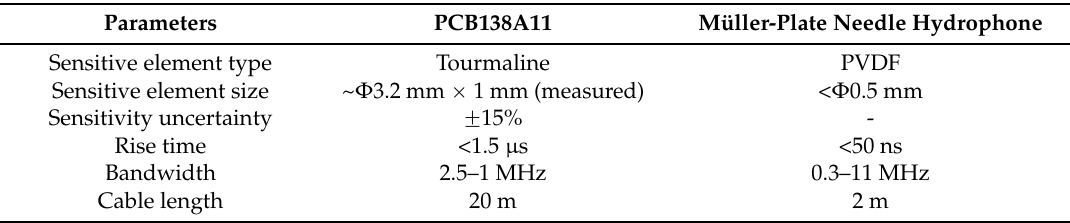
Table 1. Parameters of the PCB138 probe and the Müller-plate needle hydrophone.